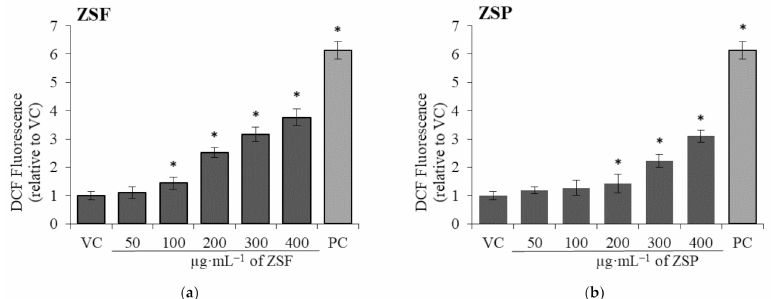
Figure 5. Intracellular reactive oxygen species (ROS) generation induced by Zanthoxylum schinifolium extracts (( a ) ZSF: Z. schinifolium fruit extract, ( b ) ZSP: Z. schinifolium pericarp extract) in WI-38 cells. Data are expressed as the mean ± SD of triplicate experiments. * Significant difference compared with the vehicle control group ( t -test, * p < 0.0486). VC, vehicle control (DMSO). PC, positive control (500 µ M H 2 O 2